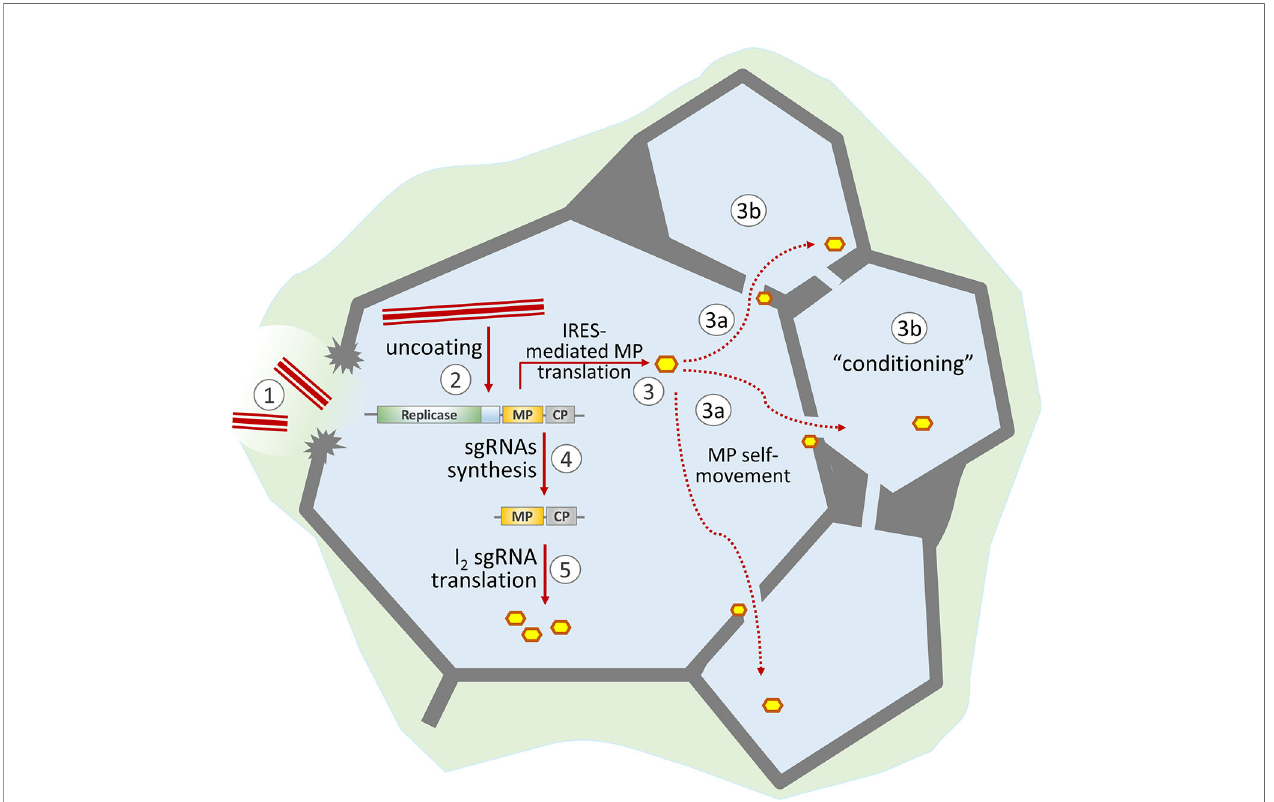
FIGURE 1 | Schematic representation of the role of MP in the development of TMV infection. TMV virions enter the cell through damage to the cell wall (1) and start uncoating (2). The released viral genomic RNA is translated both in a 5 ′ -end-dependent manner (resulting in replicase formation) and via the internal ribosome entry site (IRES) to produce MP (3). Due to its self-movement ability, MP passes to neighboring cells (3a) and “ conditions ” them for more effective viral infection (3b). The synthesized replicase transcribes viral genomic RNA and produces subgenomic RNAs (4). Further MP synthesis is mainly a result of I 2 sgRNA translation